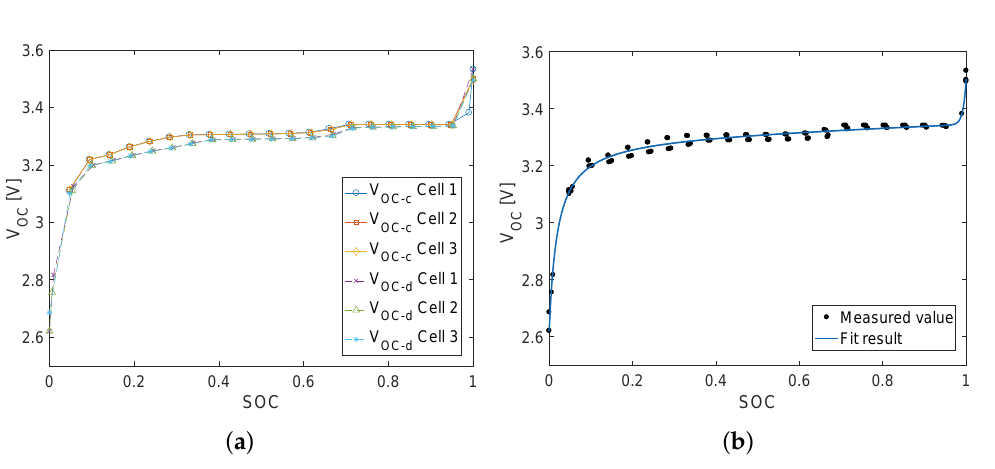
Figure 6. Measured open circuit voltage versus SOC of LFP battery: ( a ) the hysteresis of V OC when charge and discharge the battery separately; ( b ) the measured data points and the fitted curve.